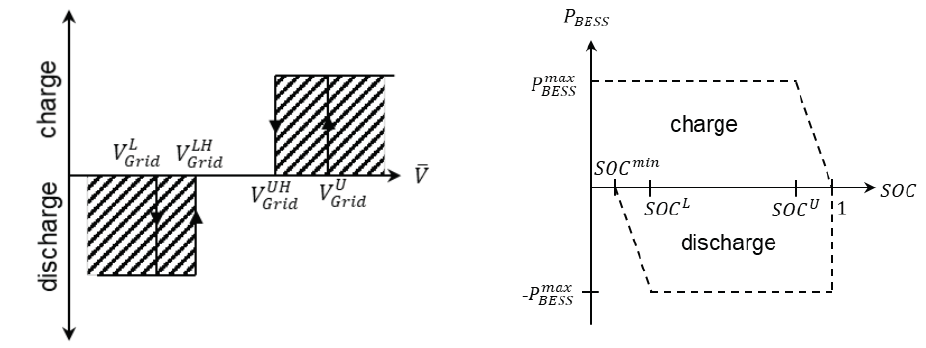
Fig. 3. Hysteresis used in the charge controller (left) and allowed region of the battery power as a function of the state of charge